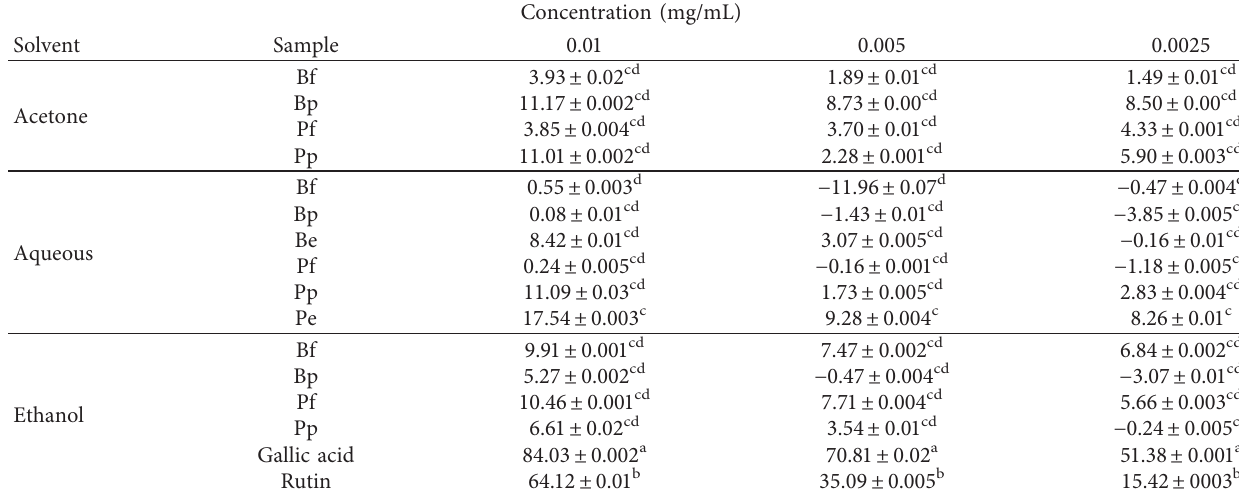
Table 3: DPPH radical scavenging activity (%) of extracts and standards.